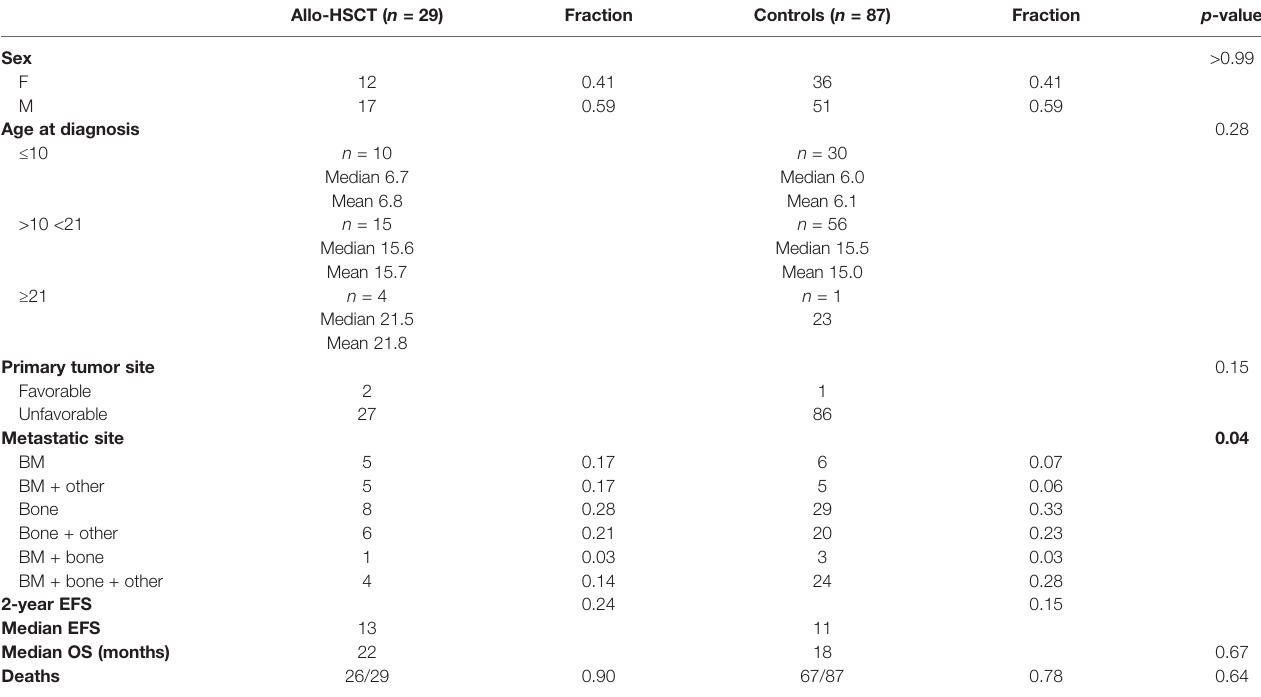
TABLE 4 | Matched-pair analysis — patients summary.